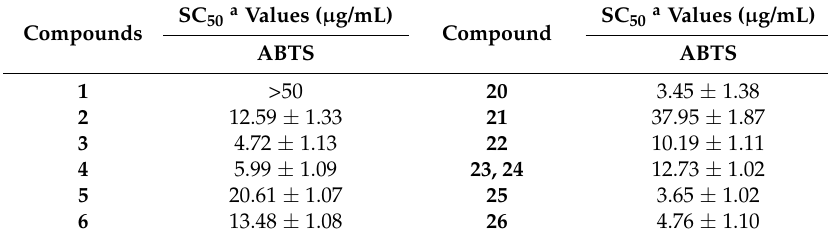
Table 3. Radical-scavenging activity of the compounds ( 1 – 37 ) isolated from X. sorbifolia husks. Compounds